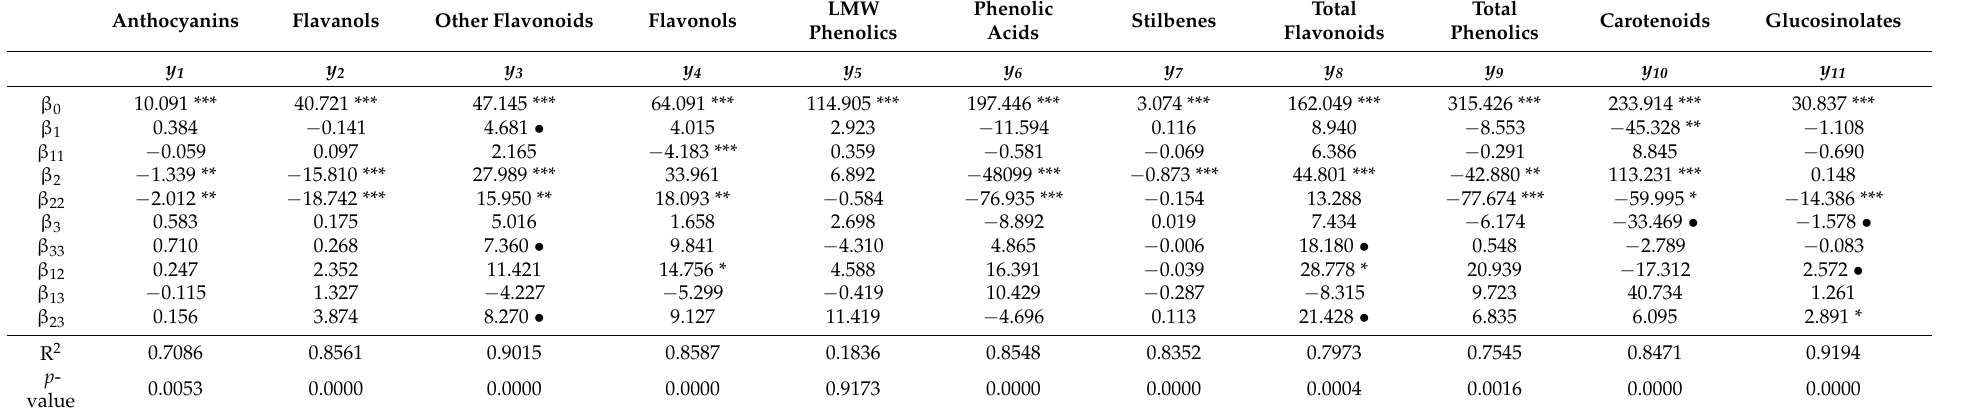
Table 3. Regression coefficients and statistical parameters that measure the correlation and significance of the models.